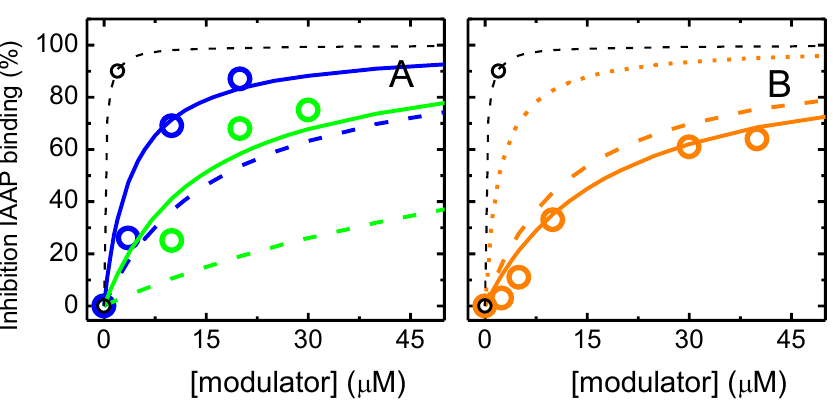
Figure 2. Inhibition of IAAP binding by NBD–C4 ( ), plot B . The results obtained with Tariquidar are also shown ( to the best fits of Equation (S2), which considers competitive inhibition. The dashed lines are the prediction from the highest affinity obtained in the ATPase assay, with the constraint K 1 ≤ K 2 (long dash) or no constraint (short